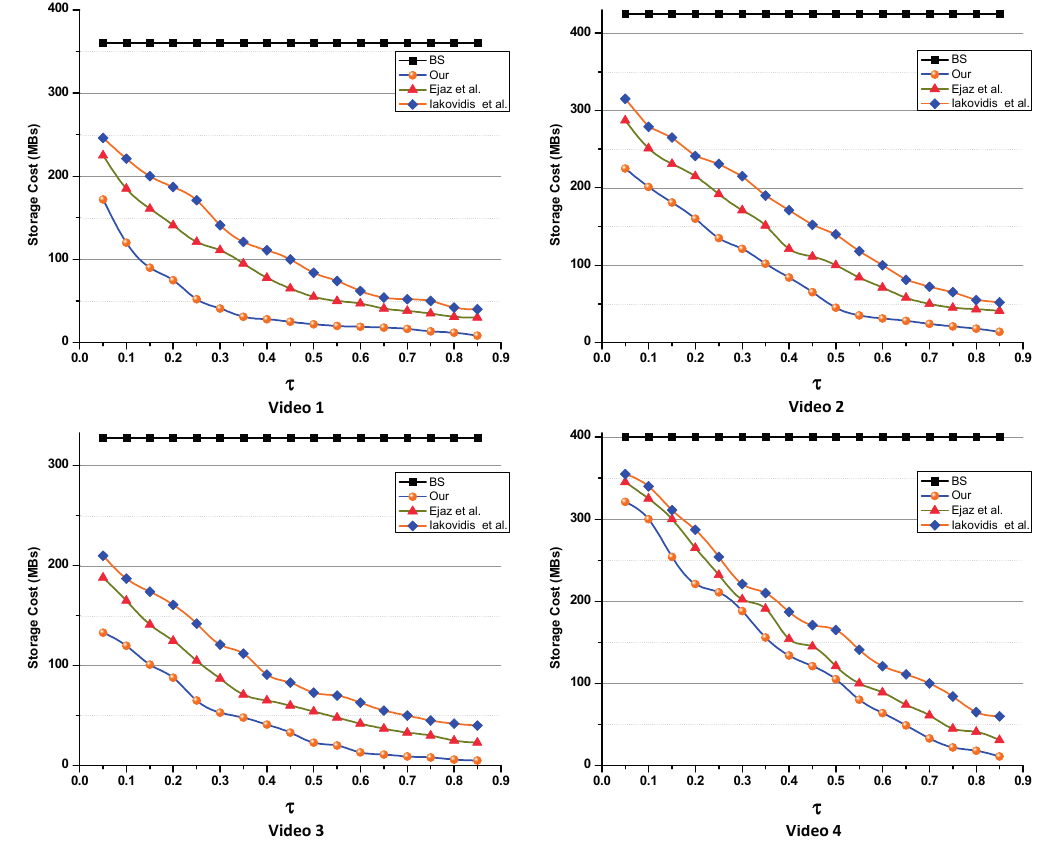
Figure 10. The impact of level of summarization on storage